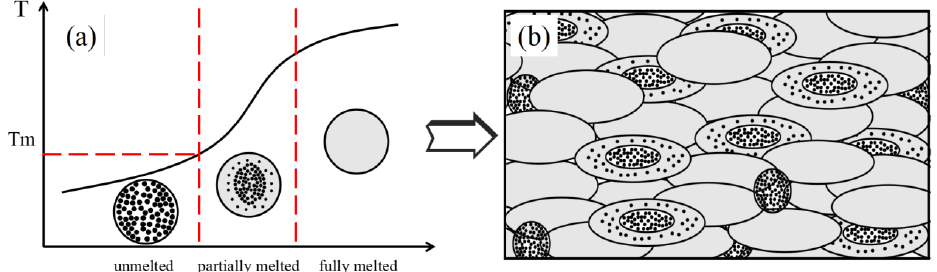
Figure 1. Schematic of formation process of plasma-sprayed nano Al 2 O 3 coating. ( a ) Melting state of particles; ( b ) nano-sized Al 2 O 3 particle-based coating models